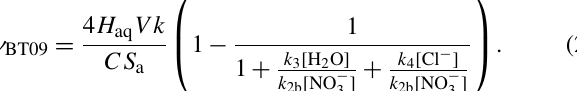
a The values of γ N 2 O 5 and ϕ ClNO 2 are derived by simulation method. ( r 2 ) between ClNO 2 and particulate nitrate are derived by regression method; the data were filtered with a correlation coefficient obtained from linear fitting threshold of